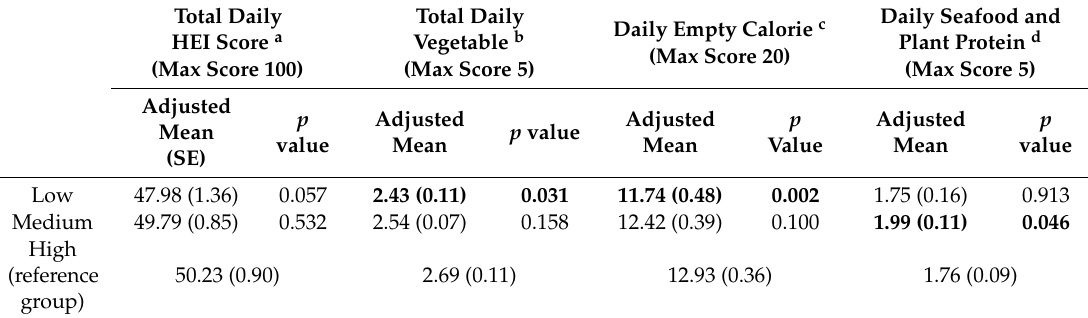
Table 4. Adjusted means from multiple linear regression models of daily HEI total score and components and cooking frequency groups among Non-Hispanic Black adults ≥ 19 years of age: NHANES 2007–2010 (observations = 2242; weighted population = 25,392,351).